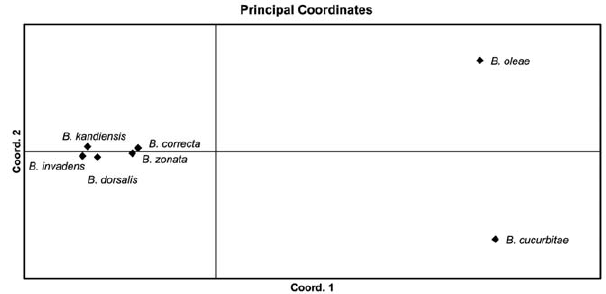
Figure 5. Plots of the principal coordinate analysis (PCA) from the covariance matrix with data standardization calculated using GenAlEx for the Bactrocera species.